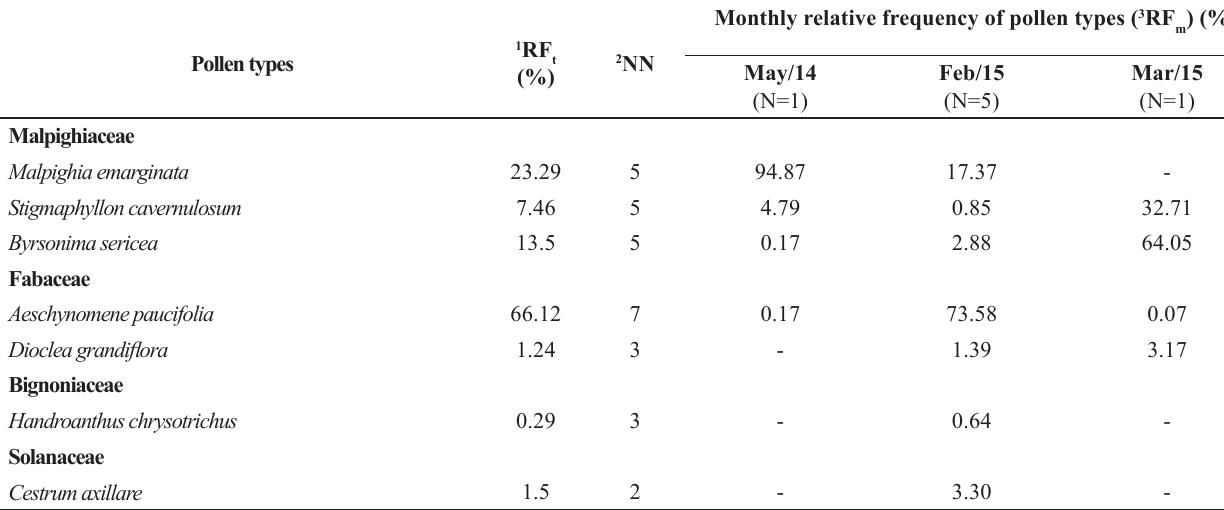
Table 3 . Relative frequencies of pollen types in the larval food from 7 nests of Centris terminata Smith, 1874 collected from campus of